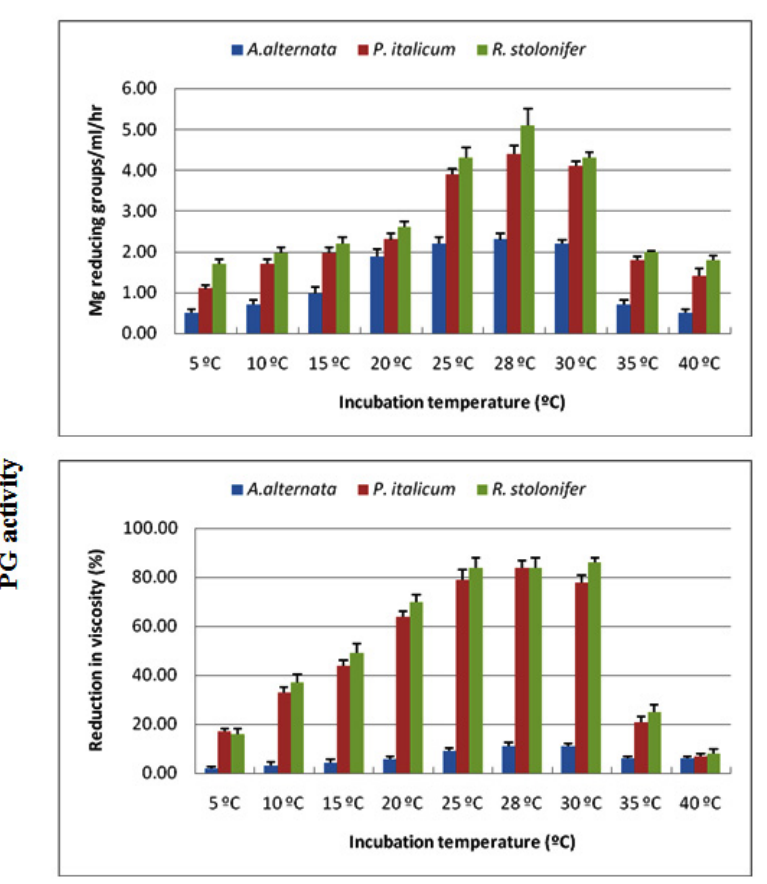
Fig. 4. Effect of incubation temperature on production of PG using Czapek Dox medium amended with pectin as carbon source for A. alternata , P. italicum and R. stolonifer after 8 days incubation in the dark. All the data are the mean of three replications and Bar on each column represents the standard